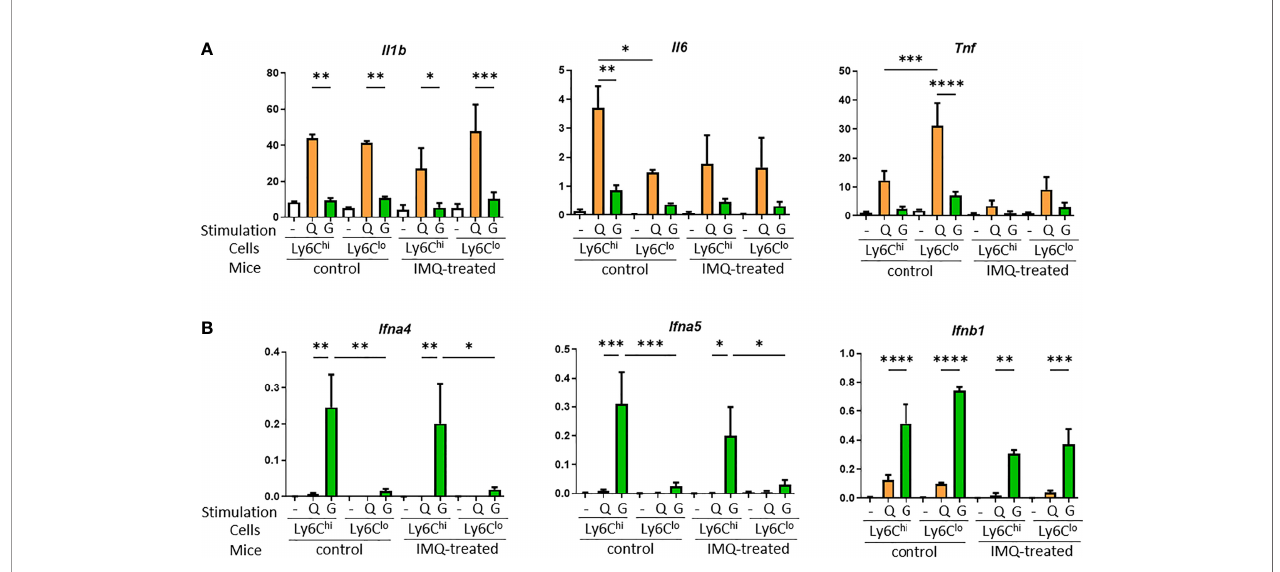
FIGURE 7 | Proin fl ammatory cytokine and type I interferon expression in monocytes upon stimulation with TLR7 or STING. Sorted monocytes from control or IMQ- treated NZB/NZW mice were stimulated by IMQ or the STING agonist, 2 ′ 3 ′ -cGAMP. (A) Proin fl ammatory cytokines were upregulated by IMQ stimulation compared with 2 ′ 3 ′ -cGAMP. (B) Type I interferon genes were upregulated by stimulation with 2 ′ 3 ′ -cGAMP. Expression of IFN – a genes were mostly limited to Ly6C hi monocytes. -, no stimulation; Q, IMQ stimulation; G, 2 ′ 3 ′ -cGAMP stimulation. Bar and horizontal lines indicate the mean and SEM. *P < 0.05, **P < 0.01, ***P < 0.001, and ****P < 0.0001 by one way ANOVA and post hoc Bonferroni ’ s Multiple Comparison